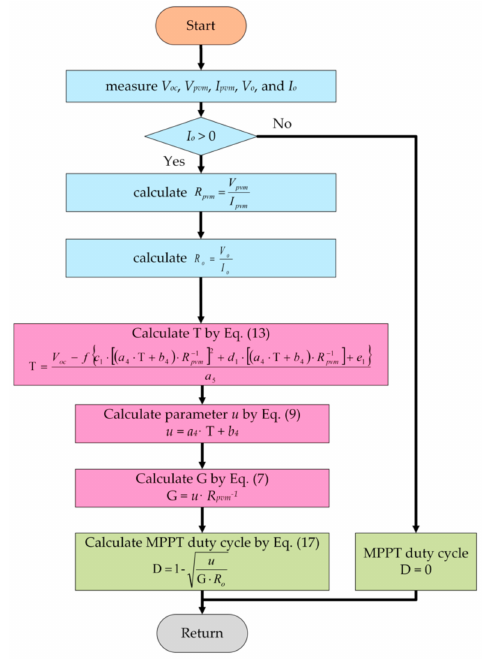
Figure 5. Proposed PVM-QR MPPT algorithm